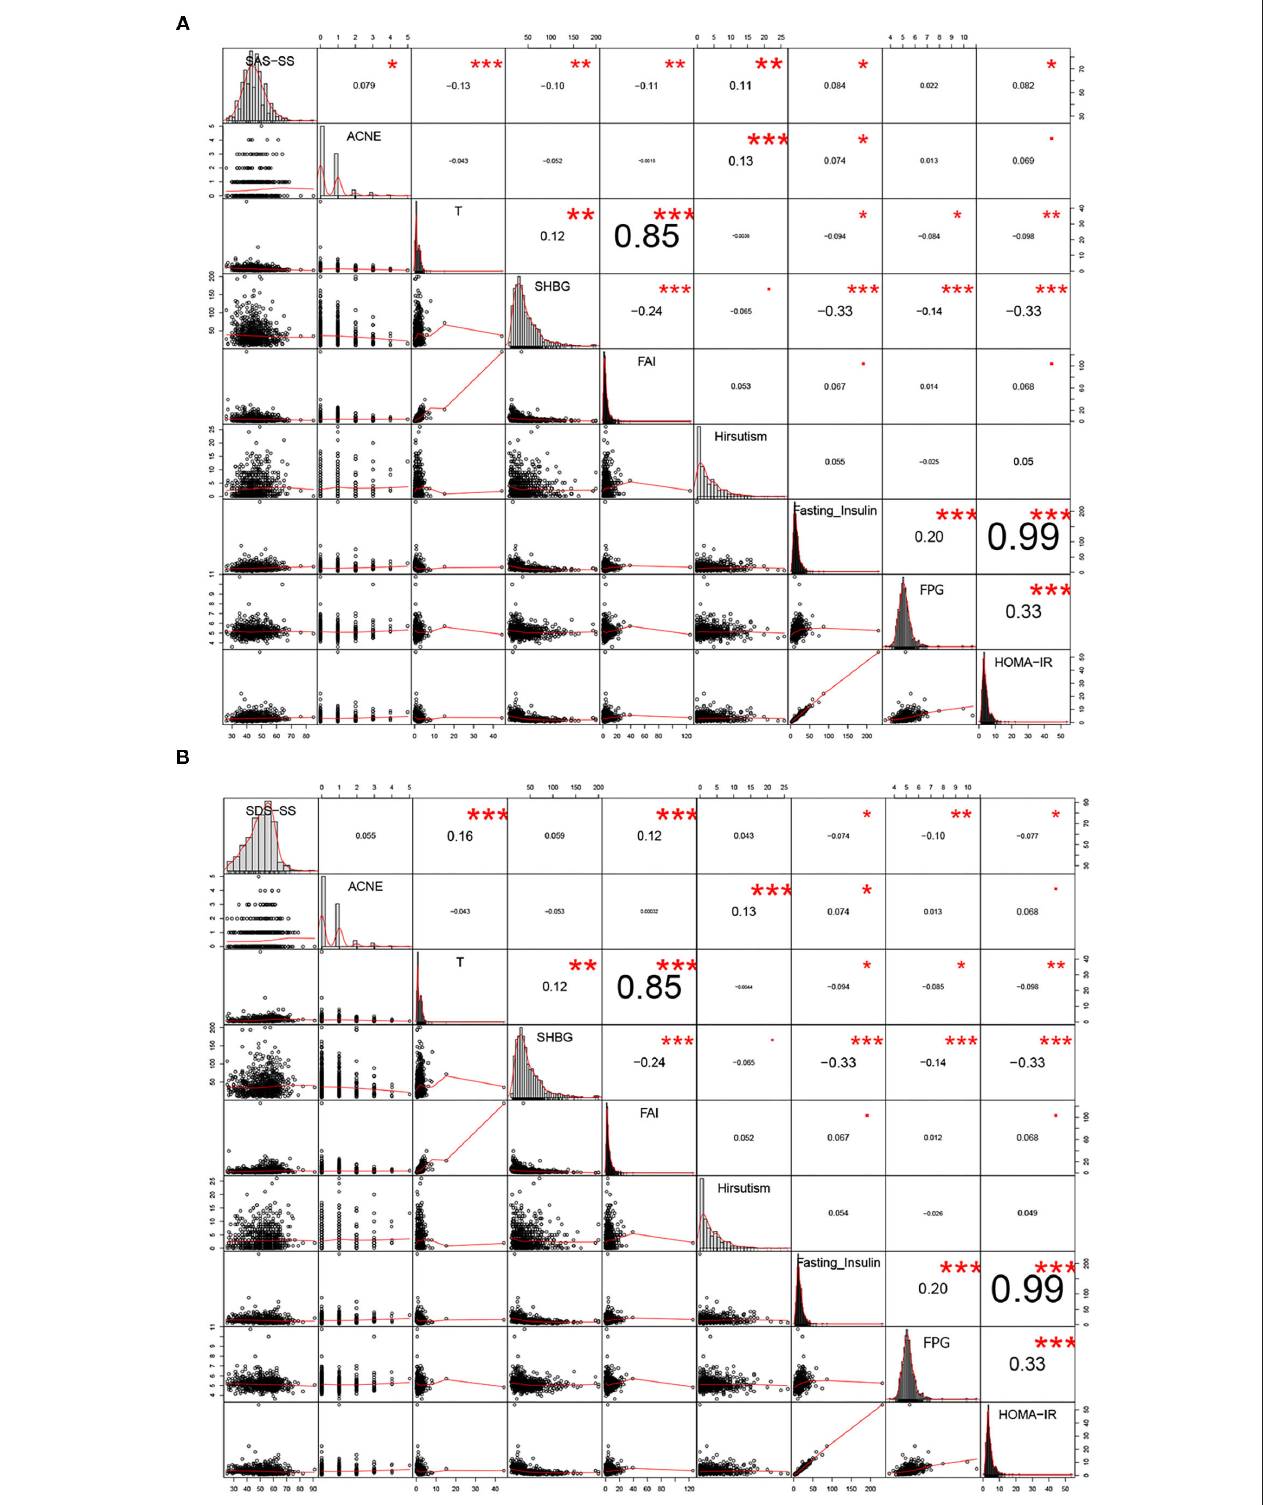
FIGURE 2 | Correlation analyses between anxiety/depression-like behaviors and the 14 clinical parameters. * P < 0.05, ** P < 0.01, *** P < 0.005.